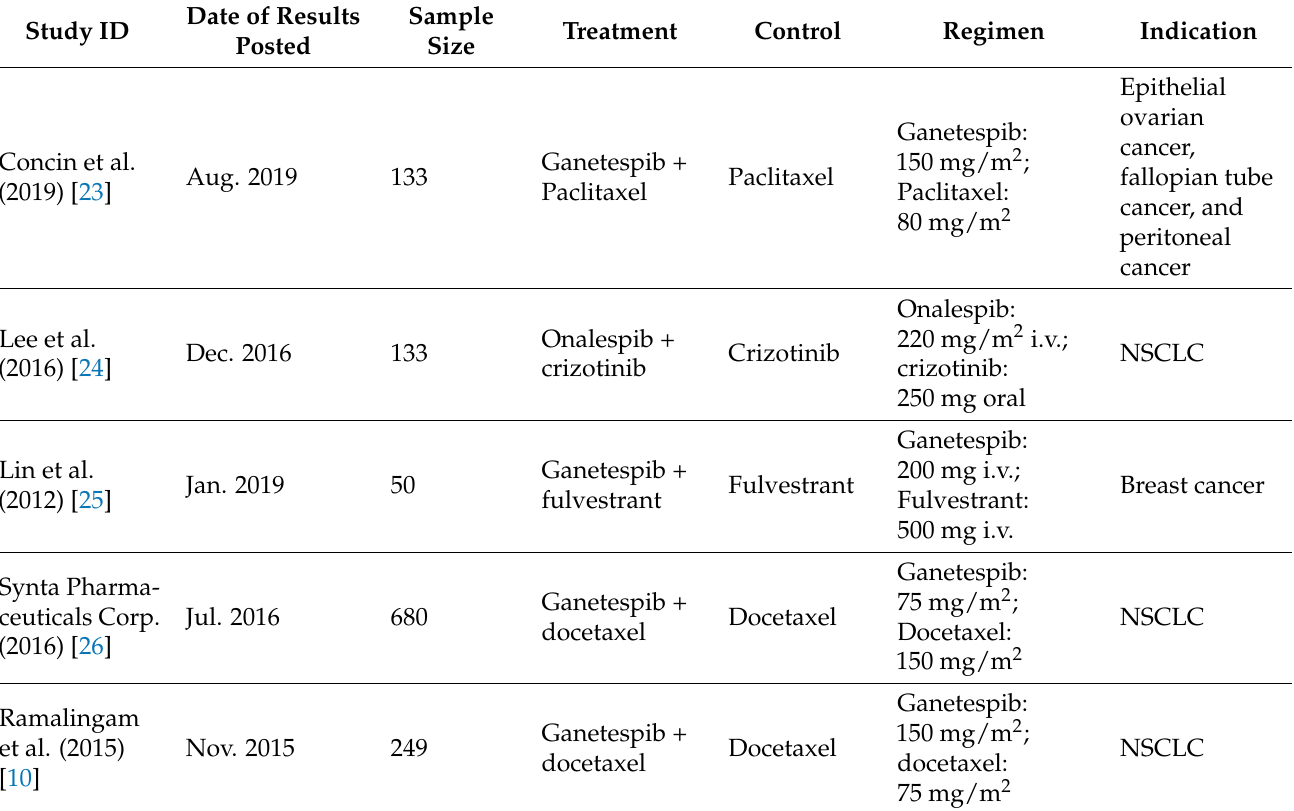
Table 2. Characteristics of randomized controlled